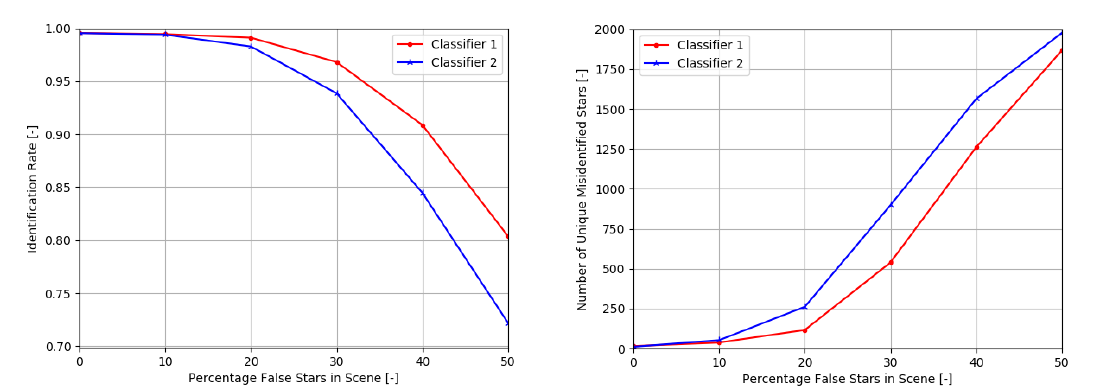
Figure 5. Identification rate of two classifiers under influence of false stars. Classifier 1 has 4096 nodes in both hidden layers, Classifier 2 has 32 in the first hidden layer and 64 nodes in the second hidden layer,